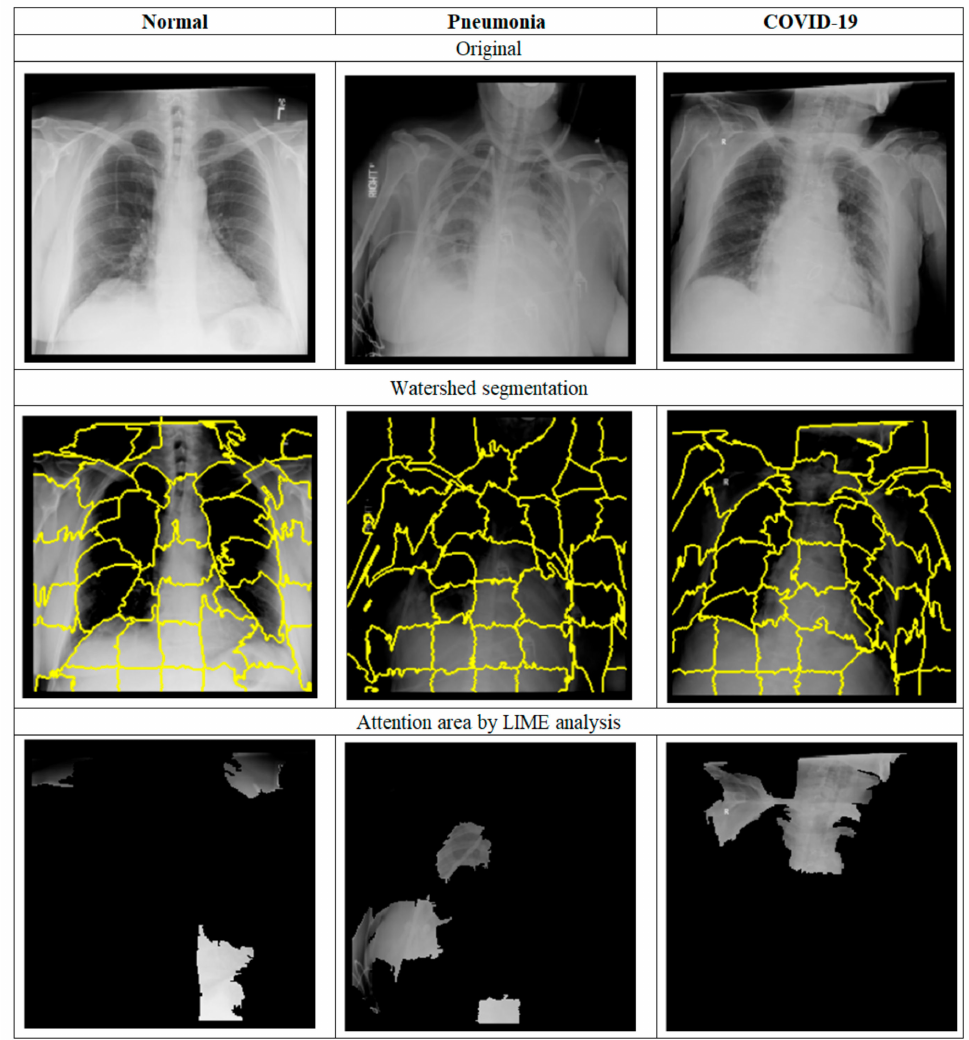
Figure 4. Images for the original Chest X-ray, watershed segmentation, and the results after the LIME